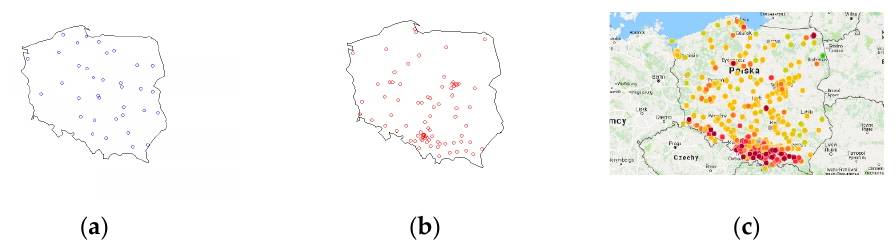
Figure 1. Shows the distribution of the monitoring stations in Poland. ( a ) Public Environmental Monitoring Stations; ( b ) independent private monitoring agency Airly’s stations (http://powietrze.gios.gov.pl/pjp/current (accessed on 4 March 2019); https://airly.org/map/pl/ (accessed on 4 March 2019)); ( c ) distribution of air pollution depending on the region in Poland—PM2.5 concentrations reading. The PM concentrations are illustrated in the form of colors varying from green (good air quality—PM2.5: 0–36 μ g/m 3 ) through orange (allowable standard—PM2.5: 36–84 µ g/m 3 ) to red (emission repeatedly exceeded and health hazard—PM2.5: 84 μ g/m 3 and higher).